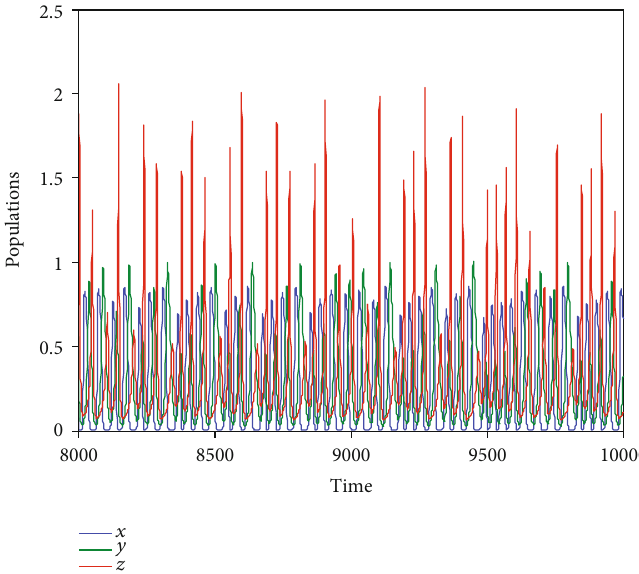
Figure 10: Time series of the chaotic attractors given in Figure 9.